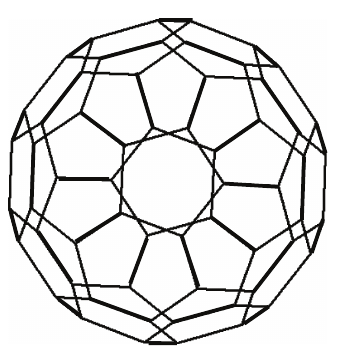
Figure 1: C 60 molecule. The most relevant electron-phonon interaction mode for EPT is the in-phase bond stretch for the short and strong bonds, drawn with thick lines.